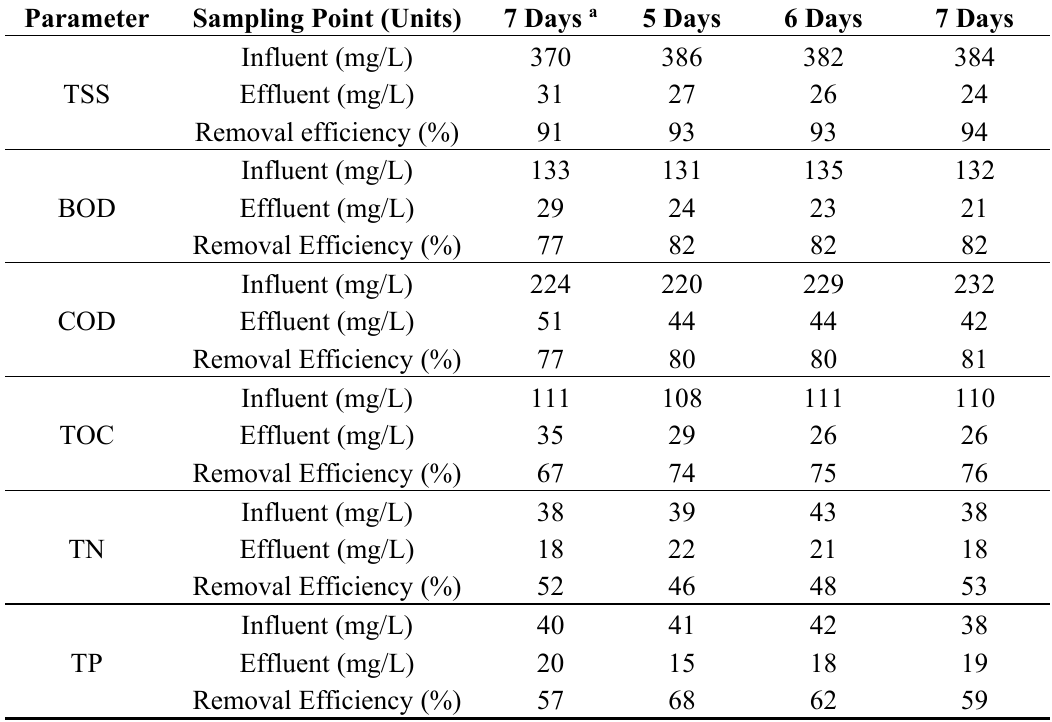
Table 1. Mean concentrations and removal efficiencies of the WWTP at variable Solids Retention Times (SRTs).